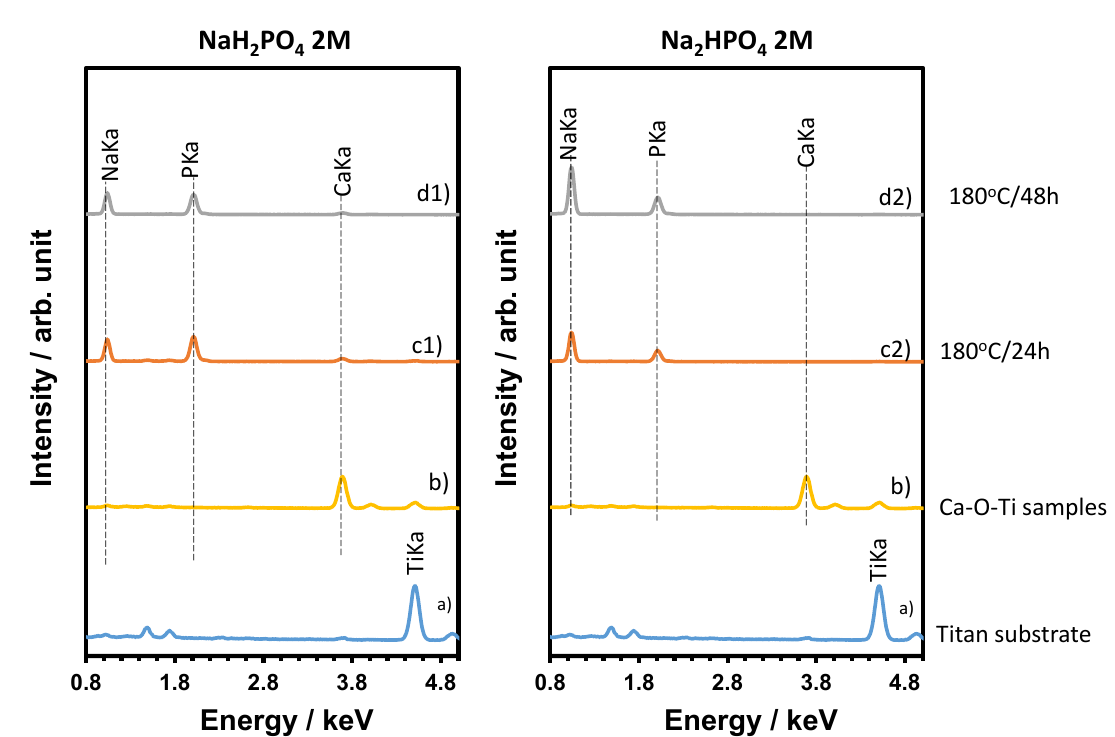
Figure 6. EDX spectra of NaKa, PKa, CaKa and TiKa elements of ( a ) Ti substrate; ( b ) the Ca–O–Ti samples; ( c1 , d1 ) Ca–O–Ti sample when immersed in the NaH 2 PO 4 solution at 180 °C for 24 and 48 h and ( c2 , d2 ) the Ca–O–Ti sample when immersed in the Na 2 HPO 4 solution at 180 °C for 24 and 48 h.